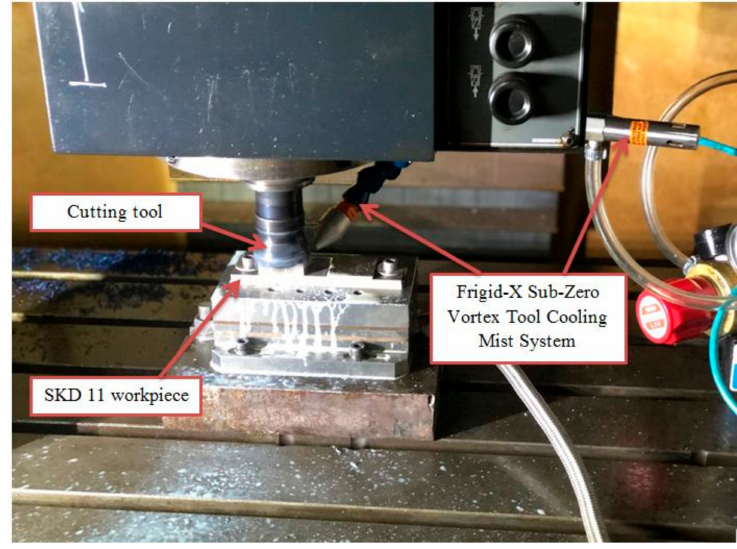
Figure 1. The experimental set